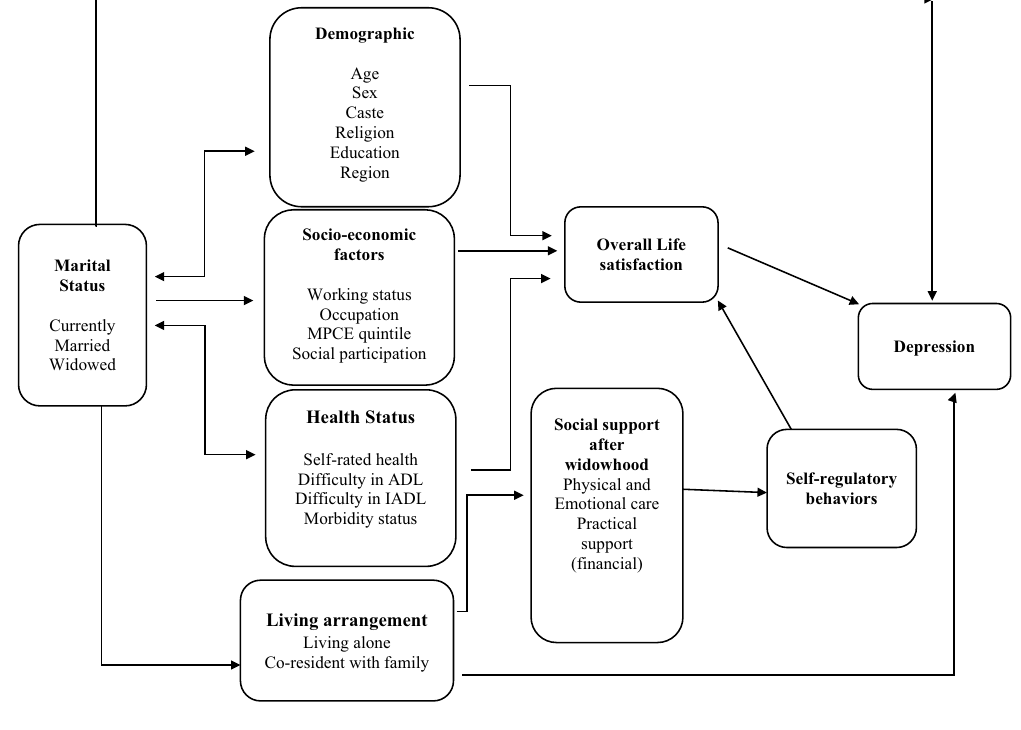
Figure 1. Theoretical